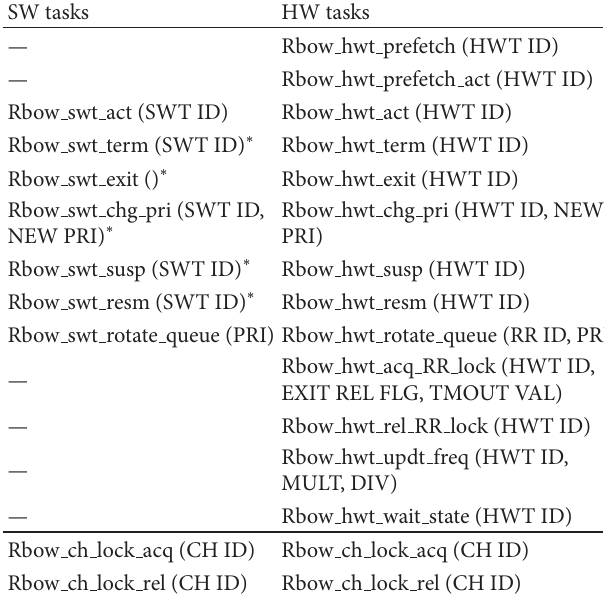
Table 1: Management